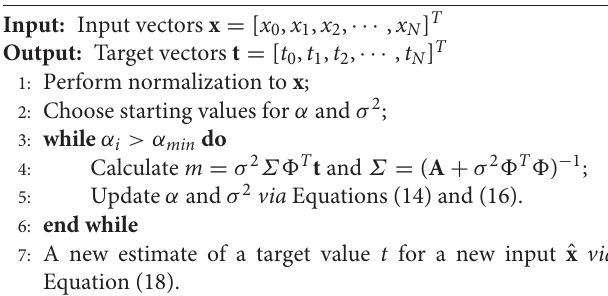
Algorithm 1 Pseudo-code of the RVM